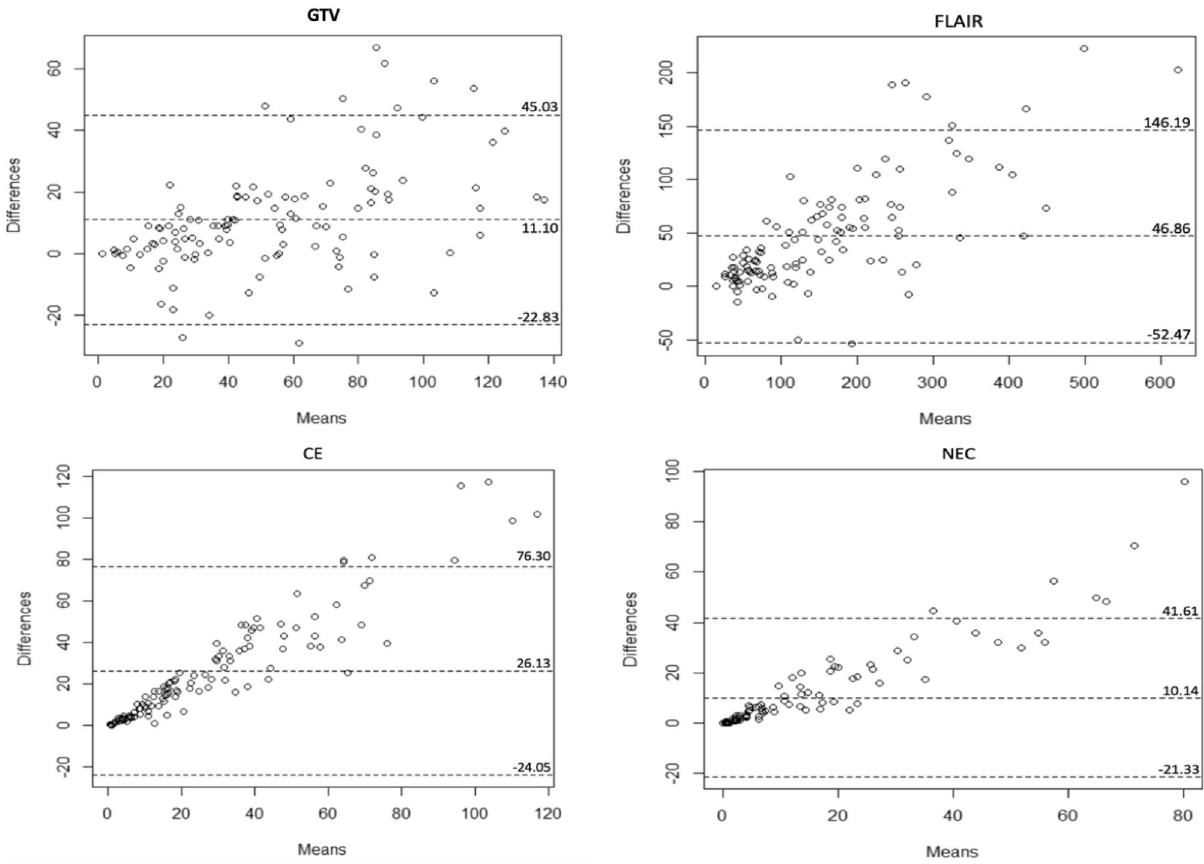
Figure 1. Bland Altman plots of the difference between the calculated volume and the measured volume in cm 3 . CE contrast-enhancement, GTV gross target volume, NEC necrosis area.